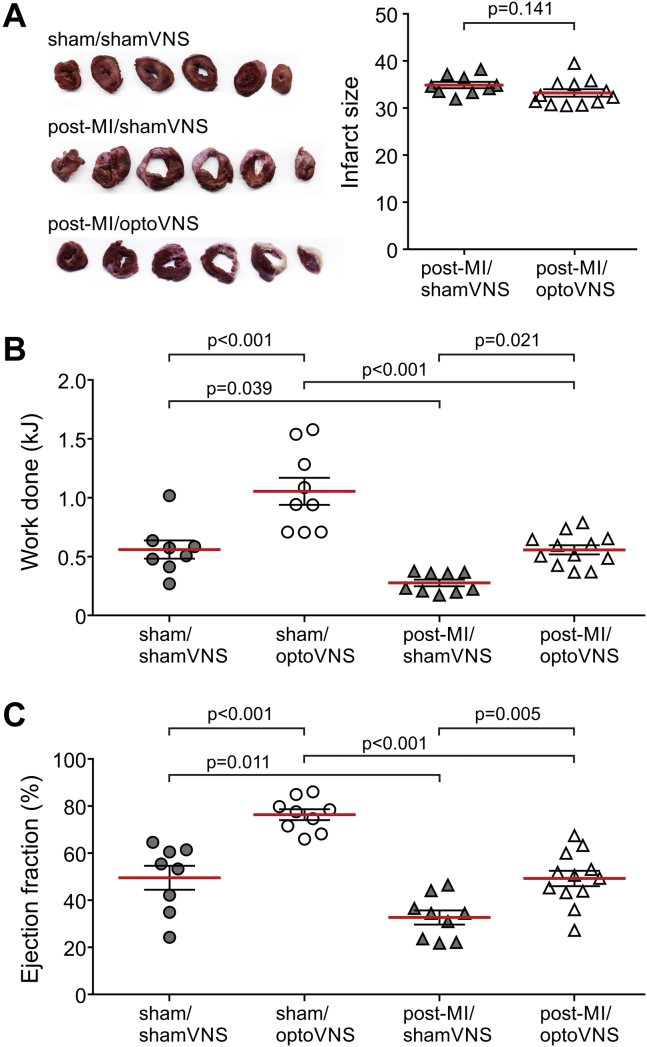
Optogenetic Stimulation of Vagal Efferent Activity Improves Exercise Capacity and Ejection Fraction in MI-Induced Heart Failure in Rats(A) Representative sections of the left ventricle (LV) from a sham-operated animal (sham/sham vagus nerve stimulation [VNS] group), an animal with MI expressing enhanced green fluorescent protein (eGFP) in the DVMN after 4 weeks of sham-stimulation (post-MI/shamVNS group), and an animal with MI expressing ChiEFtdTomato in the DVMN after 4 weeks of efferent vagus stimulation using light (post-MI/optoVNS group). Summary data illustrate infarct sizes determined by computerized planimetry of LV sections of rats transduced to express eGFP or ChiEFtdTomato by the DVMN neurons after 4 weeks of light stimulation commencing 2 days after the occlusion of the left anterior descending artery (Student’s t-test). (B and C) Summary data illustrating the exercise capacity and LV ejection fraction of rats transduced to express eGFP or ChiEFtdTomato by the DVMN neurons after 4 weeks of light stimulation commencing 2 days after the occlusion of the left anterior descending artery or sham surgery. Data are presented as individual values and mean ± SEM. Comparisons are made using 2-way analysis of variance followed by Sidak’s correction for multiple comparisons. Abbreviations as in Figure 1.